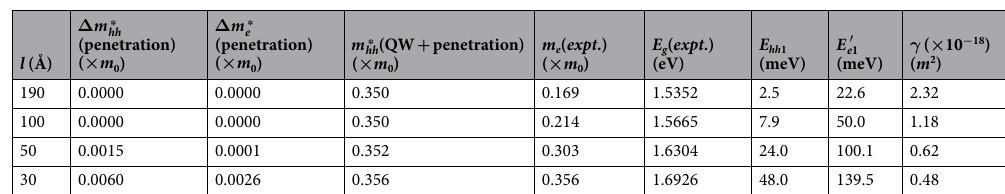
Table 2. Increase in effective mass due to penetration of wave function into the barrier layer is estimated. Ground state energy and wavenumber of QW-electrons are estimated, and subsequently the non-parabolicity factor for the four QWs is summarized. Confinement energy for heavy hole ( E hh 1 ) is estimated by solving Schrödinger equation in